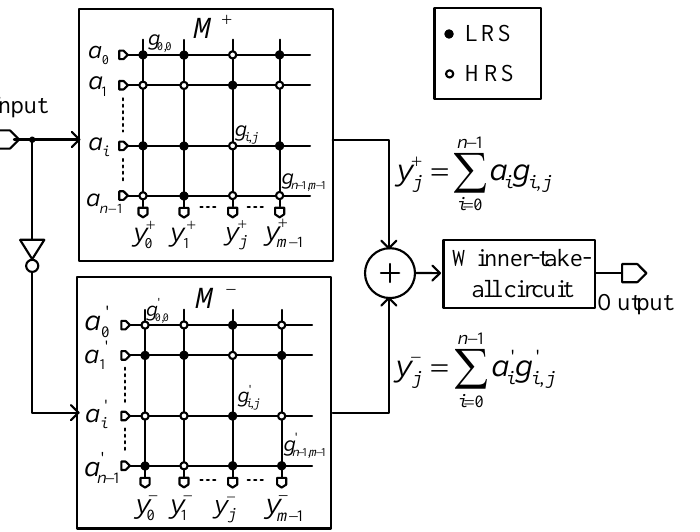
Figure 1. The complementary memristor crossbar architecture (Reproduced with permission from [14], published by SpringerOpen).